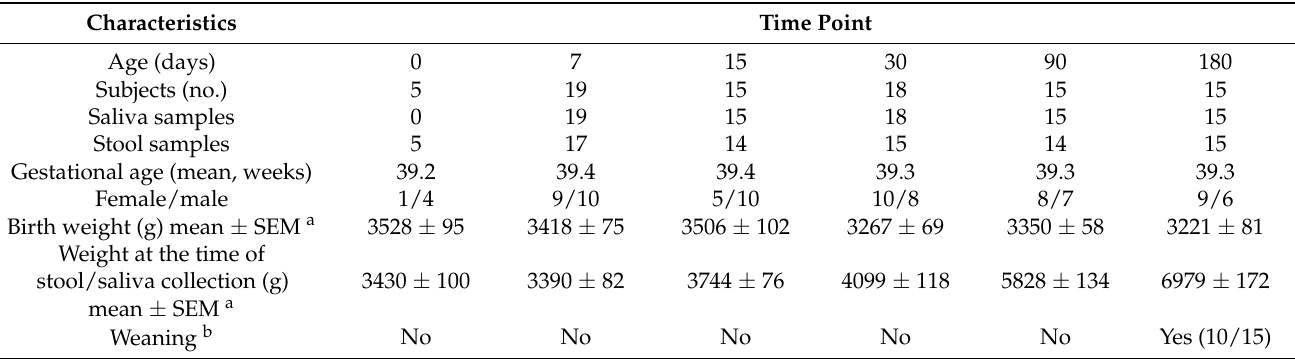
Table 1. The general characteristics of the neonate